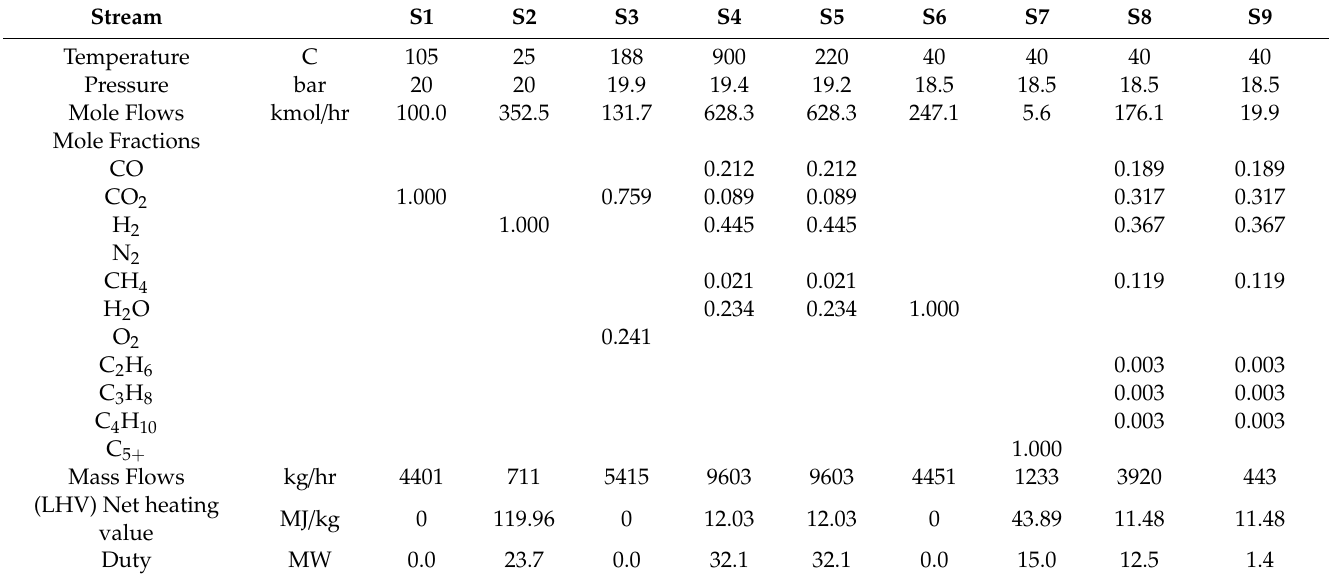
Table A5. Simulated stream results for